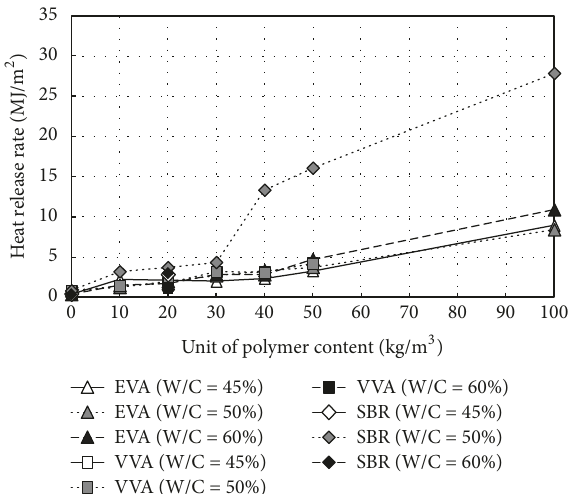
Figure 5: Total heat release amount of PCM for 20min after start of